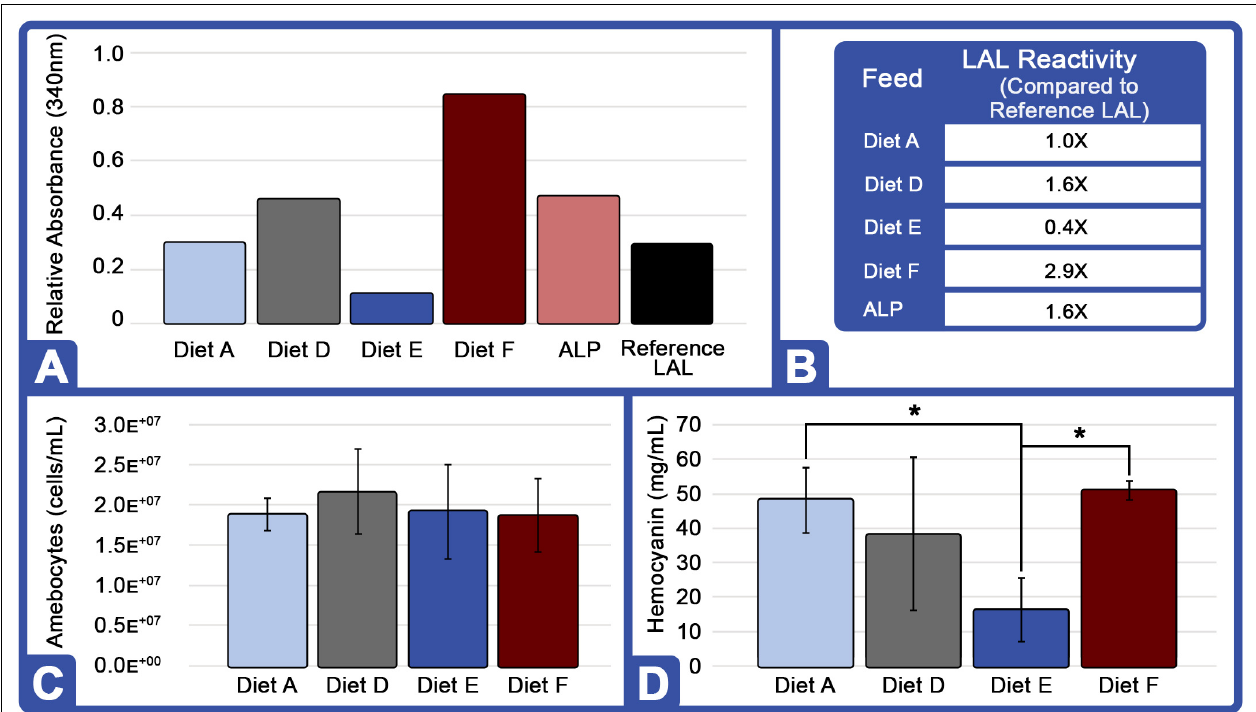
FIGURE 4 | Effect of diet on LAL reactivity, amebocyte density, and hemocyanin concentration (Feed Study 3): (A) Aquaculture LAL reactivity from four diets over 8-week period vs. reference LAL at 50 EU/mL LPS concentration. Equal protein amounts from each Diet (75 µ g; total = 300 µ g) were pooled and tested for clotting [ALP: Aquaculture Lysate Pool (Diet A, D, E, F)] and reactivity to endotoxins was measured by absorbance at 340 nm. (B) Aquaculture LAL reactivity to endotoxins vs. reference LAL. (C) Amebocyte density of aquaculture HSC determined microscopically on a hemocytometer. (D) Hc concentration of aquaculture HSC hemolymph measured by UV spectrophotometry (280 nm). Results are represented as mean ± SD between individual HSCs in each cohort ( n = 6). * p < 0.05 compared to Diet